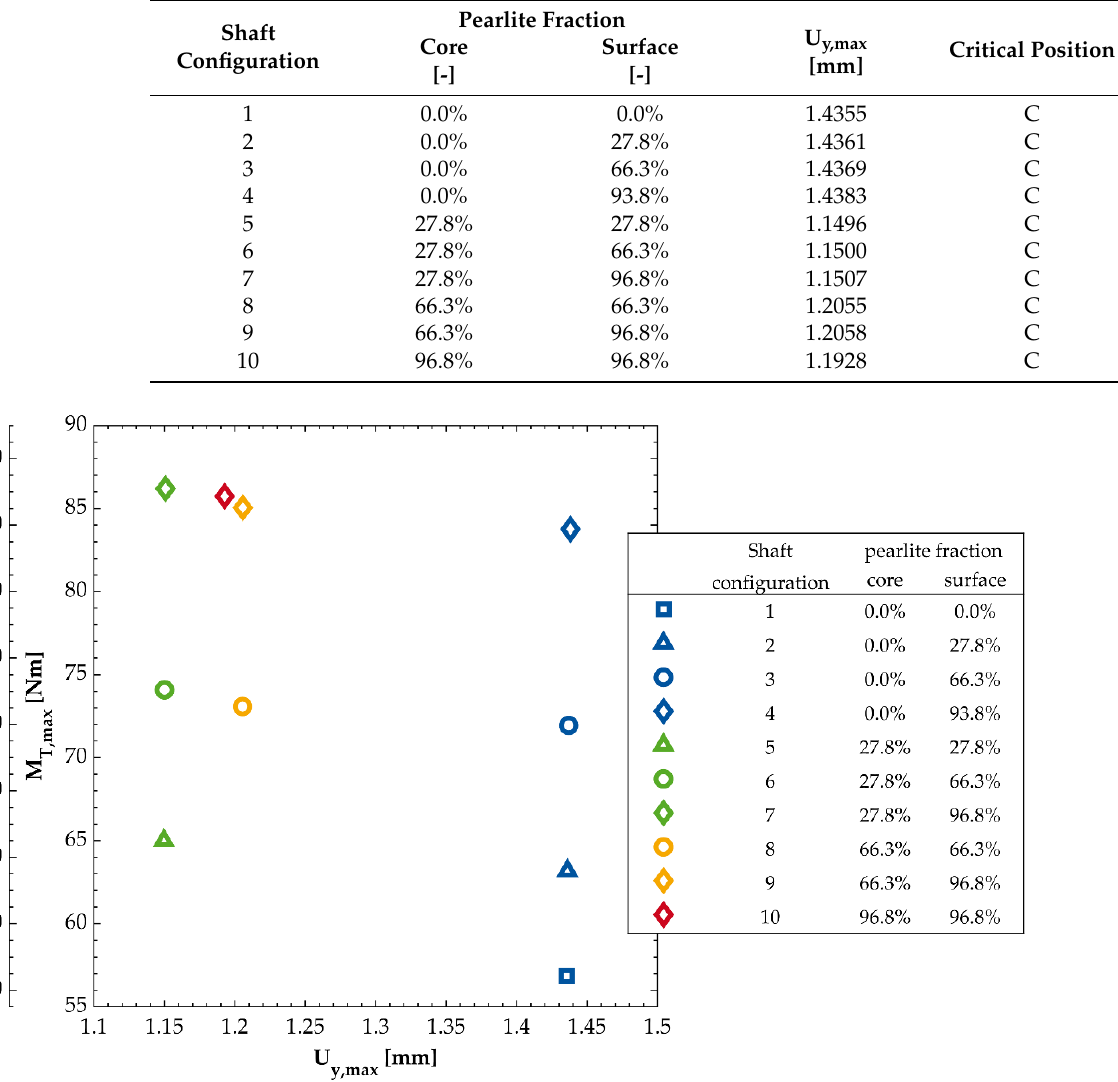
Table 7. Maximum allowable static bending displacement U y,max.